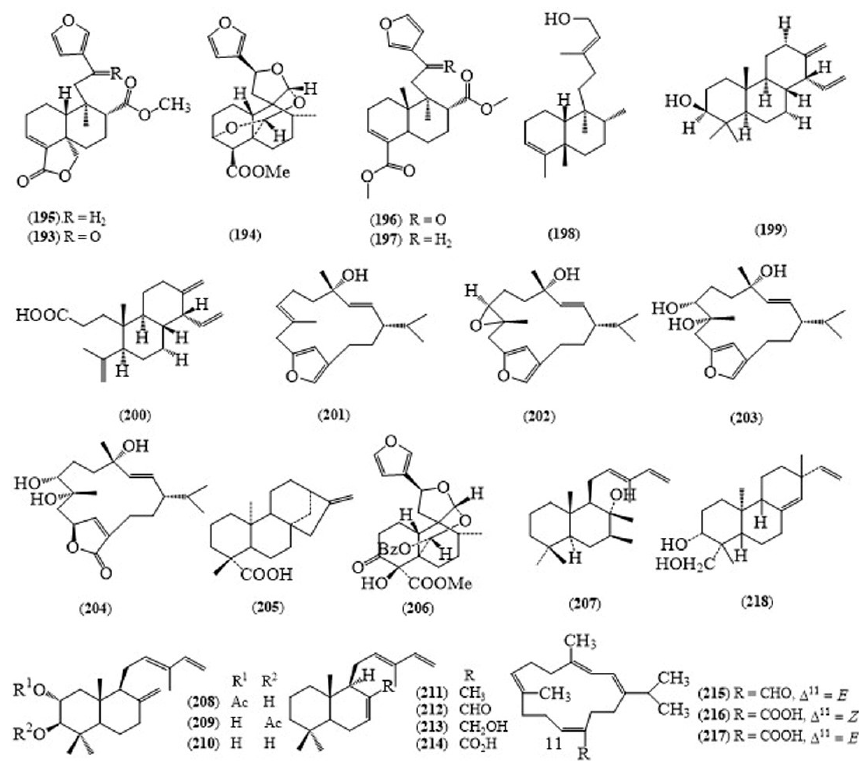
Figure 15. Structures of selected compounds isolated from Croton oblongifolius.